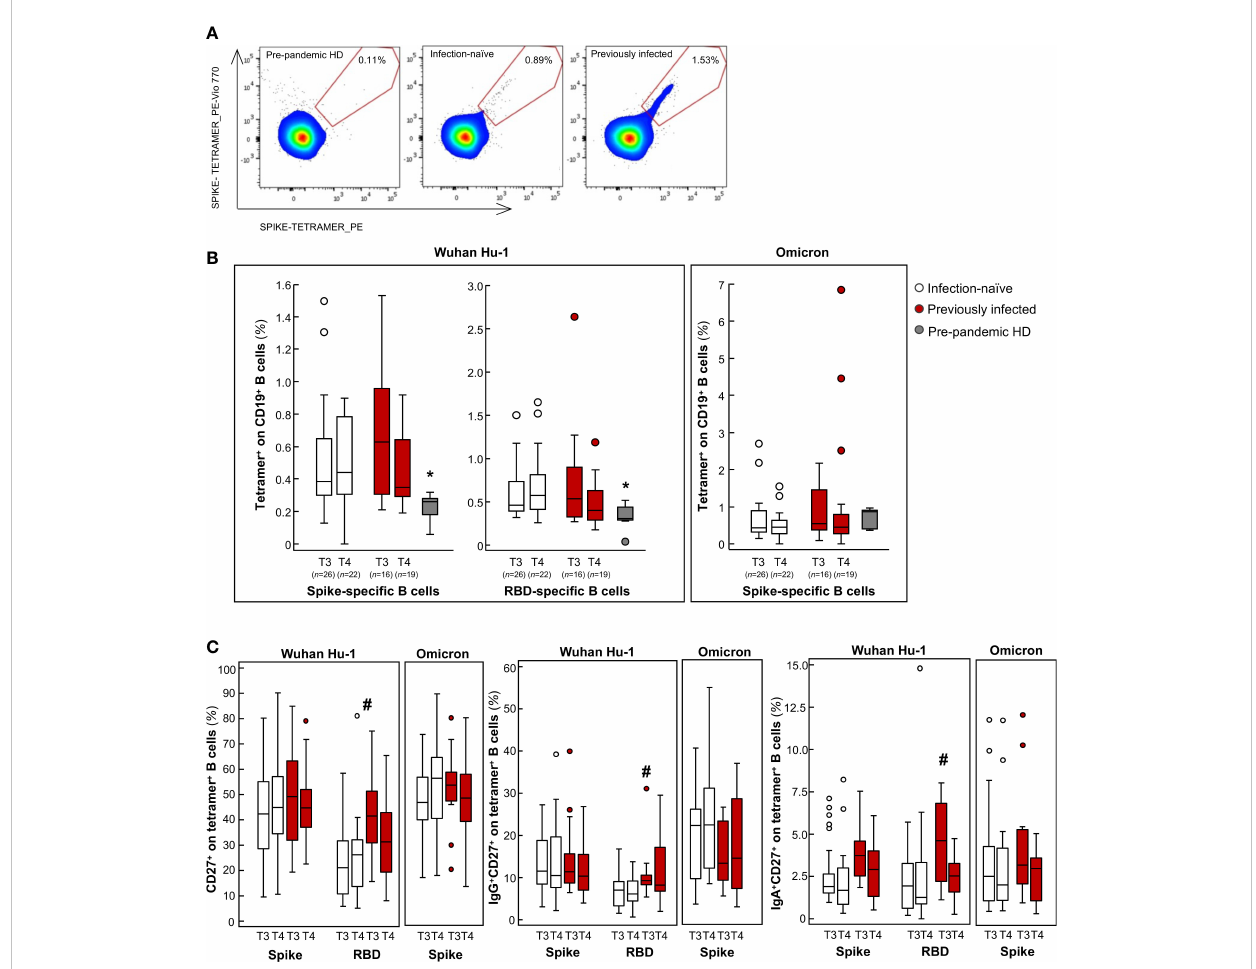
FIGURE 2 Analysis of B cell frequency in infection-naïve and previously infected vaccine recipients over time. (A) Representative fl ow cytometry pseudocolor plots of spike-speci fi c B cells in pre-pandemic healthy donor (HD), in an infection-naïve and a previously infected subject. (B, C) Percentages of tetramer + on CD19 + B cells (B) and the percentages of memory CD27 + , IgG + CD27 + and IgA + CD27 + B cells on tetramer + B cells (C) are shown for the spike and RBD protein of the Wuhan Hu-1 SARS-CoV-2 and in response to the B.1.1.529.1 (Omicron) spike protein in infection-naïve and previously infected subjects at 9 months after primary vaccination (T3) and 3 months after the booster dose (T4), as well as for pre-pandemic HD. * p-value <0.05 vs infection-naïve and previously infected subjects at T3 and T4; # p-value <0.05 vs infection-naïve subjects at T3. The sample size ( n ) for all B cell analyses is indicated in brackets in panel (B)